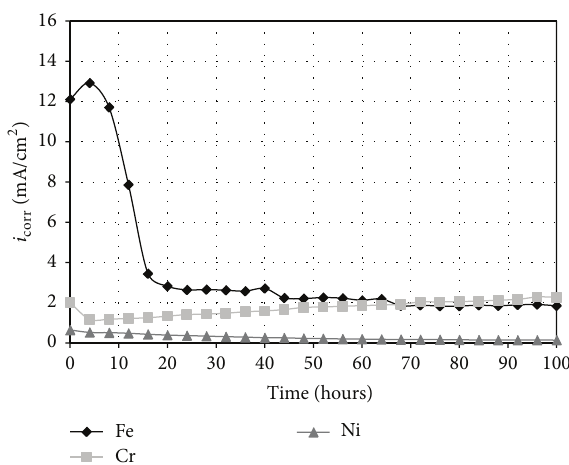
Figure 10: Current density corrosion ( 𝑖 exposed to NaVO 3 at 700 ∘ C in static